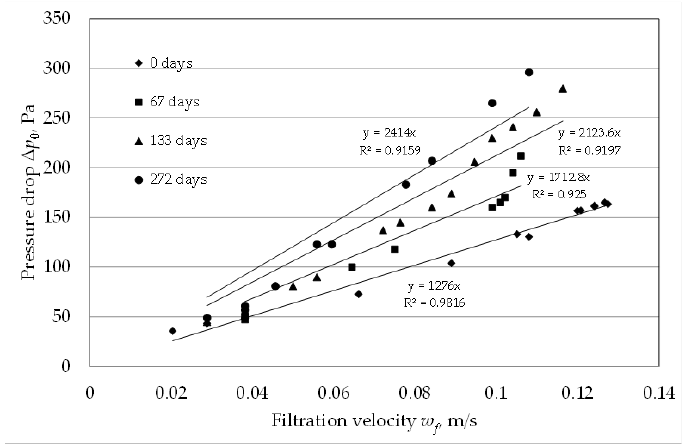
Figure 5. Pressure drop across clean filter media from narrow surfaces treatment line.